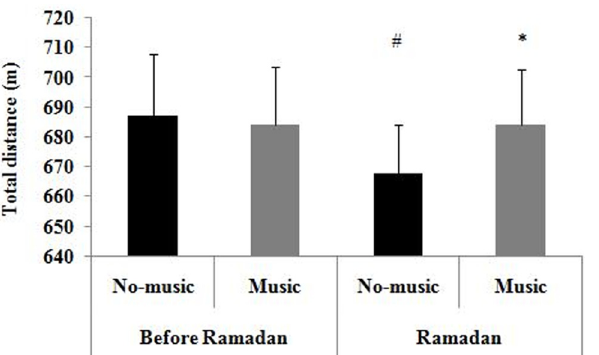
Fig 1. Means and standard deviations for total distance according to Music and Ramadan period conditions. #: significantly different compared to before Ramadan for the same music condition. * : significantly different compared to no-music condition during the same